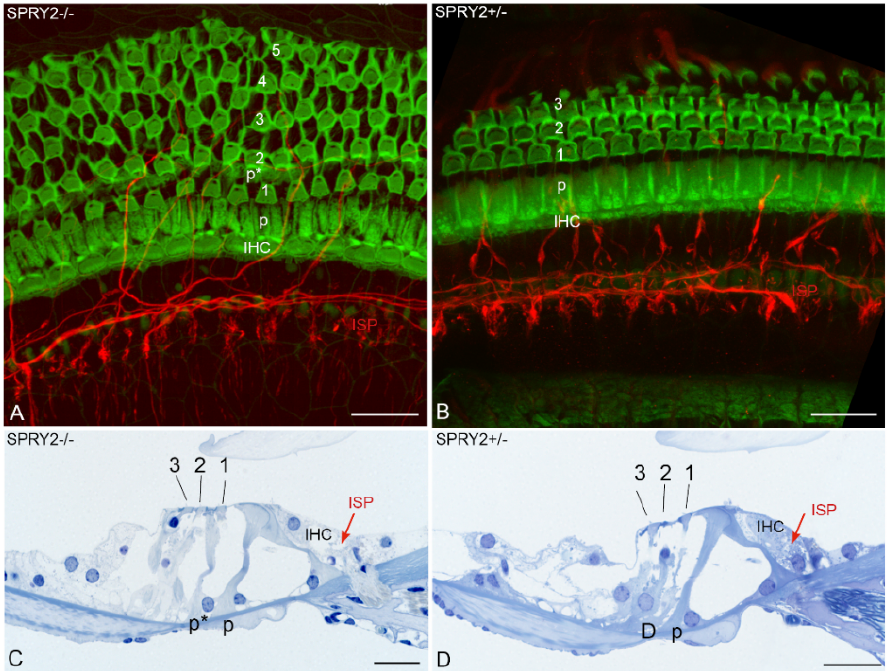
Figure 4. Middle turns of the cochlea from one-month-old SPRY2 − / − ( A , C ) and SPRY2+/ − ( B , D ) knockout mice. Whole mount preparations ( A , B ) were stained with fluorescent phalloidin (green) which labels the actin-rich hair cells and an anti-neurofilament 200 antibody (red) labeling nerve fibers. Images were acquired with a confocal microscope. SPRY2 − / − mice revealed up to five rows of outer hair cells (OHCs; A , 1–5) that are arranged less ordered compared to SPRY2+/ − mice that reveal the typical regular mosaic pattern of sensory and supporting cells with three rows of OHCs ( B , 1–3). Afferent and efferent nerve fibers intermingle in the inner spiral plexus (ISP) underneath the inner hair cell (IHC) and appear normal. The additional pillar cell (p*) is best visible in plastic embedded semithin sections ( C , D ). D shows the conventional cytoarchitecture in a SPRY2+/ − littermate with a normal outer pillar cell (p). An additional outer pillar cell (p* in subfigure ( C )) resembles more the first row of Deiters’ cells (D in subfigure ( D )). Scale bars = 20µm.